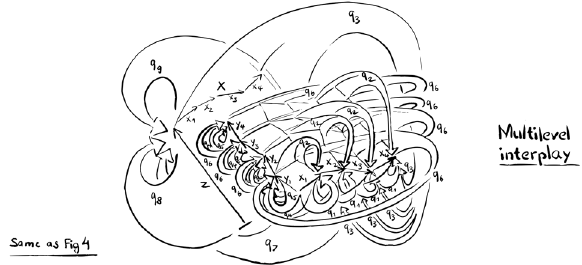
Fig. 11 The model of multi-level interplay of Fig. 4 visualized in lines- planes style. To prove that it is possible, I have added here a lines-planes representation of the model of Fig. 4. This is for the most advanced readers only. The model shows interplay that takes place between overarching categories and subcategories. Easily recognizable are the fl ows q 2 along the diagonal of the matrix. They are a result of interplay between any given subcategory x i and its matching pair y i . By contrast the fl ows q 6 are a result from interplay between any given subcategory y i and the entire overarching category x , with x = x 1 + x 2 + x 3 + x 4 . Evidently, these latter fl ows include all interplay that takes place not only along the diagonal but also off the diagonal of the matrix. We have applied this model to explain cycles of diversi fi cation. The present visual is helpful in this respect because it makes evident that the model works like a machine that computes diversity. If the sum of q 2 x i y i values along the diagonal of the matrix is high, diversity is low, and the x i values are held in check, whereas if the sum of all pairwise q 6 x i y j values that include all interplay that takes place off the diagonal are high, diversity is high, and the x i values are not held in check (Simpson ’ s index is calculated by dividing the fi rst set of values by the latter, which is why diversity is low in the previous and high in the latter situation. See also Fig. 12 in Annex 2) If this model is only studied in terms of the diversity of x and y , it can be simpli fi ed to yield a formula for cycles of diversi fi cation equivalent to the basic model of interplay of Fig. 2D; (Annex 2).